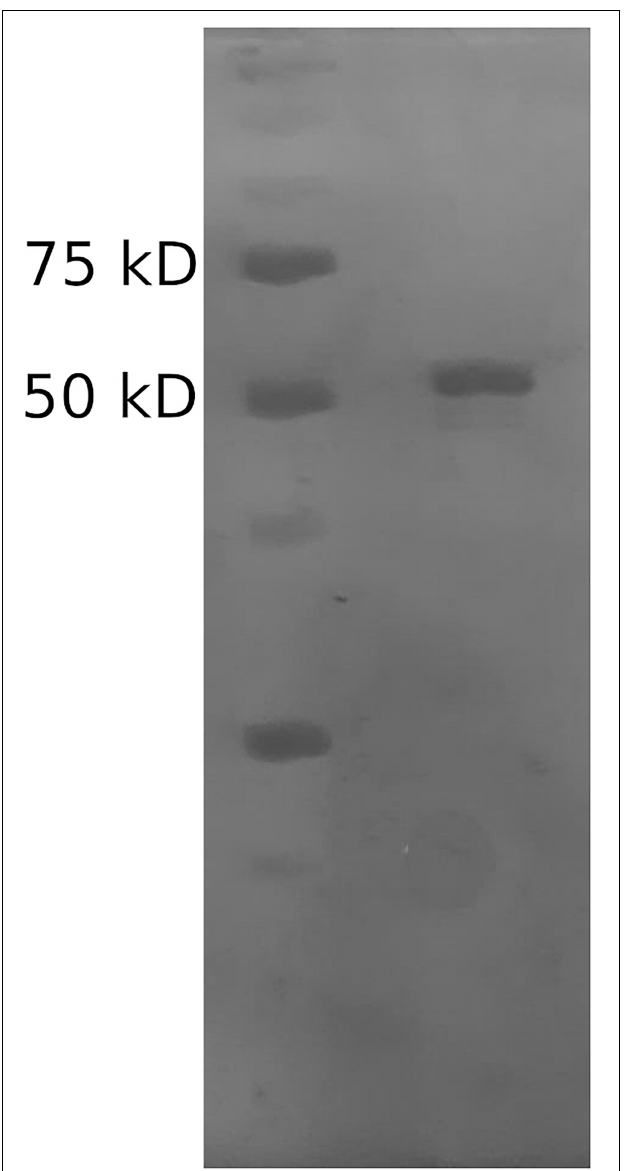
FIGURE 2 | Purified His-tagged Mle046 protein. The size of the purified protein agrees with the predicted size (62 kD).